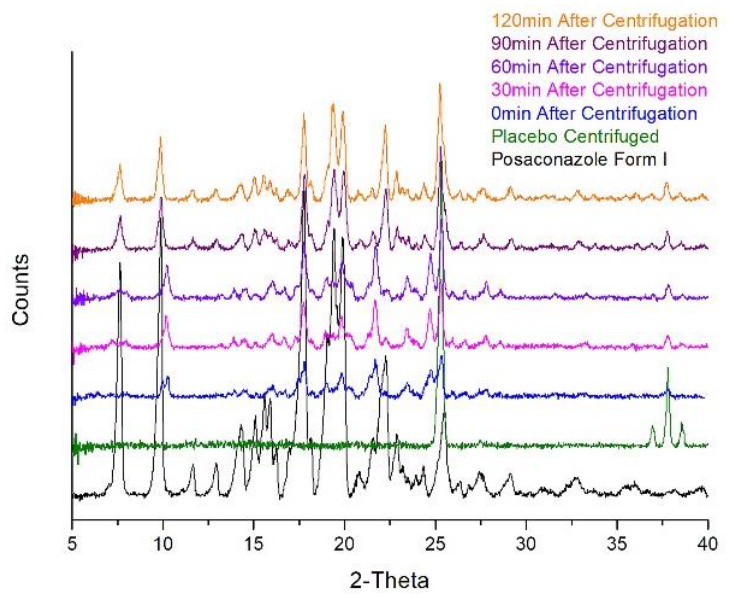
Figure 4. Stability of Posaconazole Form-S in the oral suspension ′ s precipitate: XRPD patterns of Posaconazole Form I ( black line ), precipitate of Posaconazole oral suspension ′ s placebo ( green line ) and precipitate of Posaconazole oral suspension immediately after centrifugation ( blue line ), 30 min ( magenta line ), 60 min ( violet line ), 90 min ( purple line ) and 120 min ( orange line ).